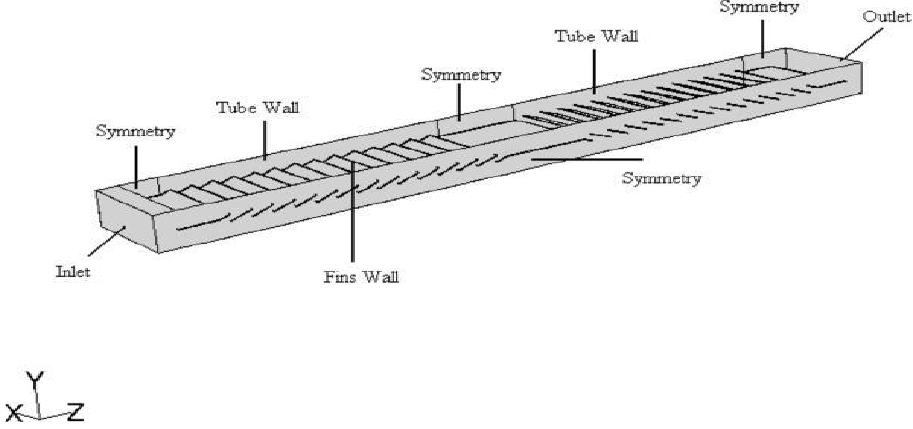
Figure 2: Computational domain louver fins